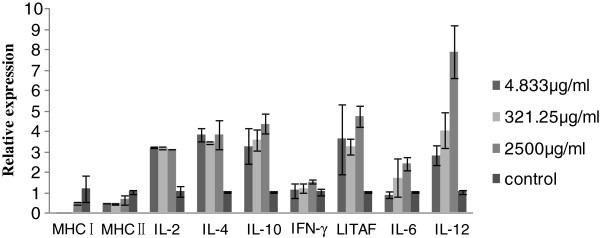
Illustrates the real-time quantitative PCR analysis of major histocompatibility complexes (MHC) I, MHC II, and cytokines IL-2, IL-4, IL-10, IFN-γ, LITAF, IL-6 and IL-12 in Astragalus polysaccharide-treated chicken embryo fibroblasts. Expression levels of IL-2, IL-4, IL-10, LITAF and IL-12 were higher in the Astragalus polysaccharide treatment groups than for the corresponding controls. IL-12 attained the highest expression level.